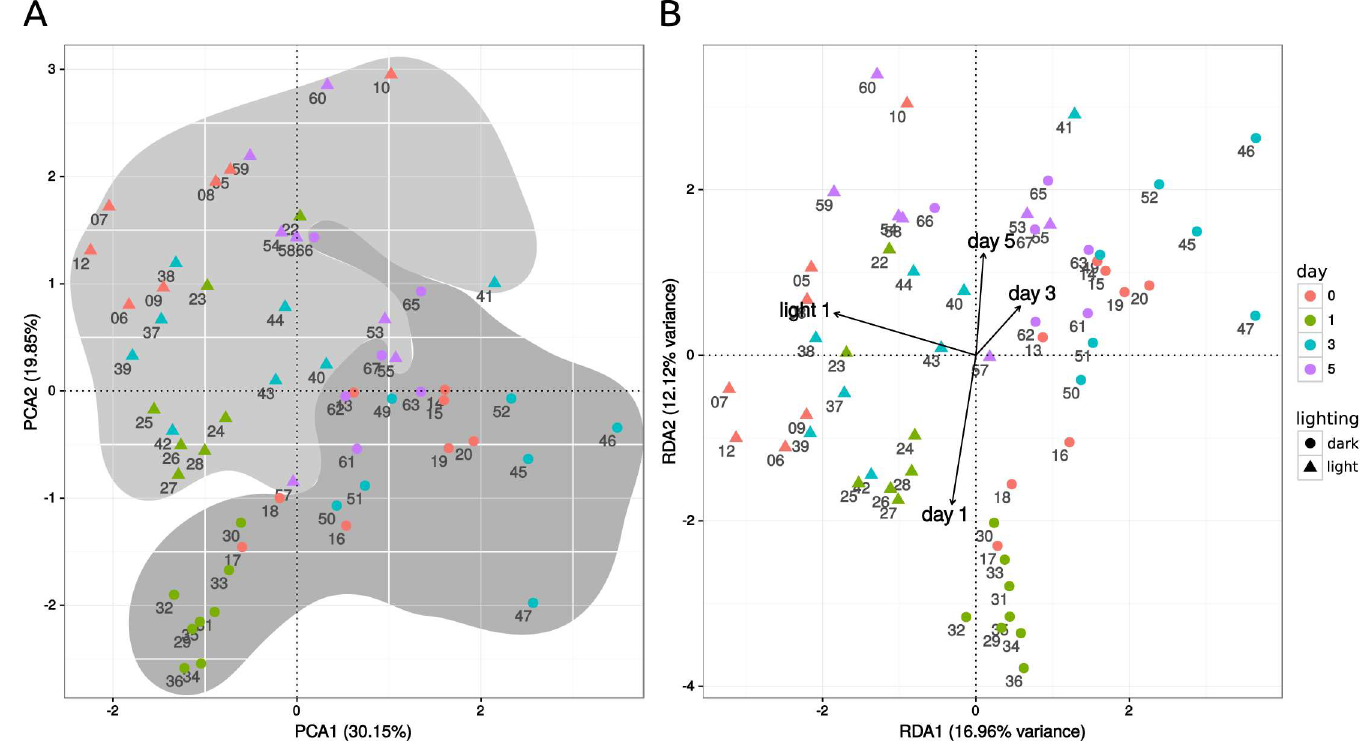
Fig 4. Ordination plots. (A) Principalcomponentanalysis(PCA) and (B) redundancy analysis(RDA) of normalized intensity matrix. Samples are depicted as numbers, different days are indicatedby coloursand symbols show sampleskept under dark (circle) and light (triangle)conditions. The coloured background indicates the separationbetweensamples in light (light grey) and dark (dark grey) conditionsin the PCA. Arrows in (B) show significantfactors of the reducedmodel. Sampleswere numbered for readabilityaccordingto S1 Table.